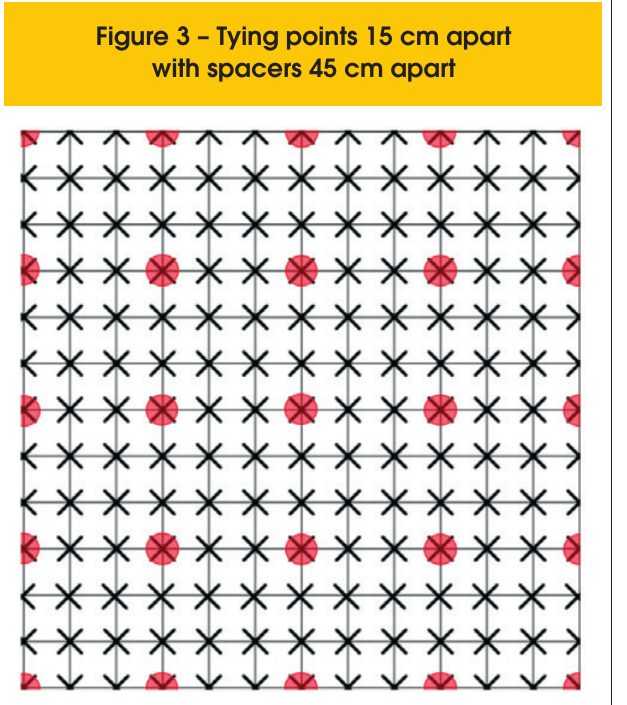
Figure 4 – Tying points 30 cm apart with spacers 45 cm